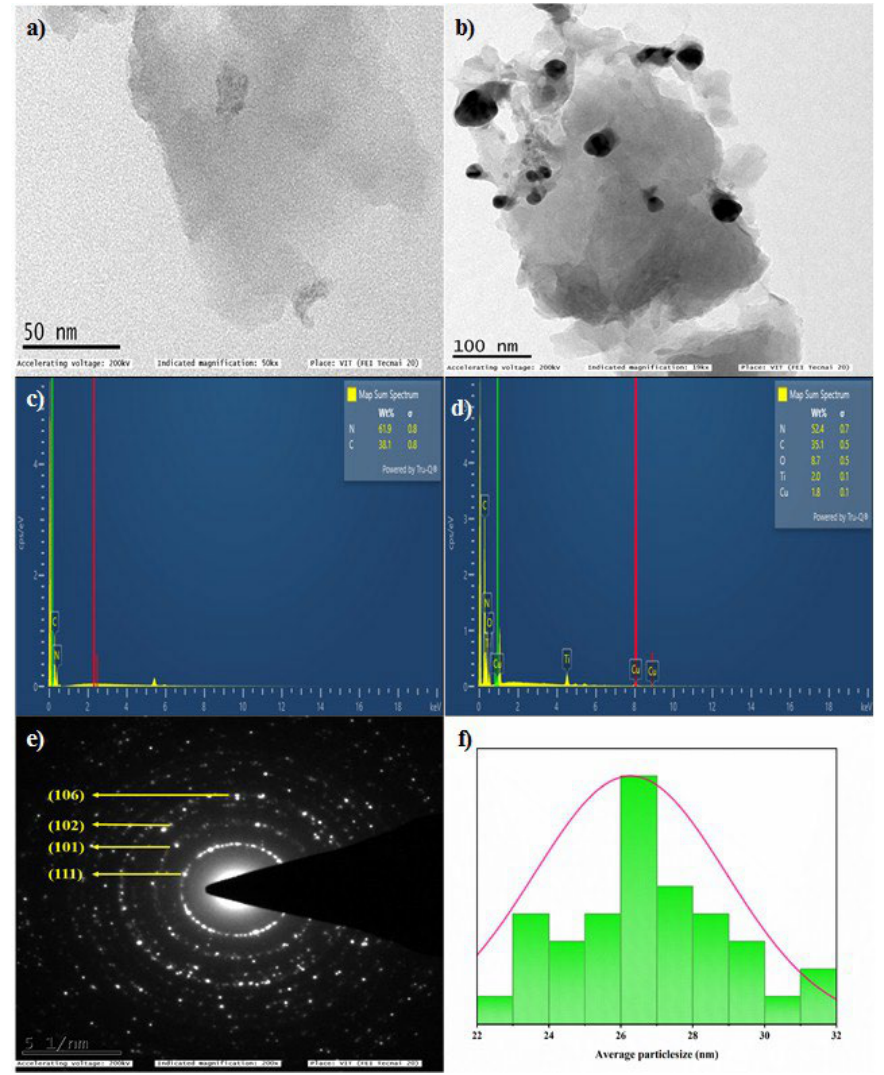
Figure 4. ( a , b ) TEM images, ( c , d ) EDS spectra of g-C 3 N 5 , 10% CN5CT nanocomposite ( e ) SEAD pat- tern of 10% CN5CT. ( f ) Average particle size of Cu 3 TiO 4 nanoparticles in 10% CN5CT.